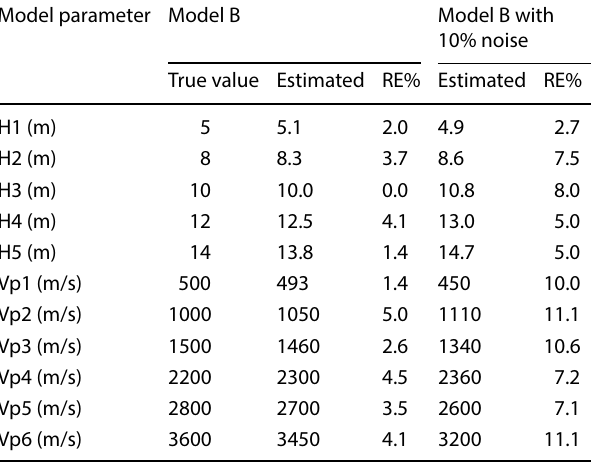
Table 3 The inversion of model B with and without noise Model parameter Model